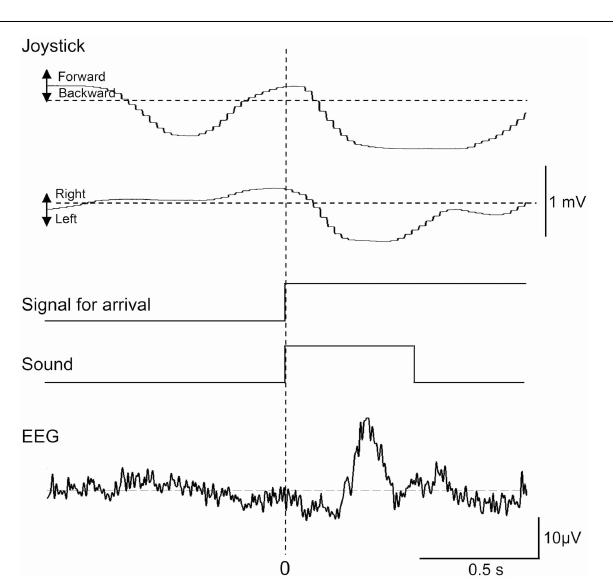
FIGURE 3 | Representative recordings of joystick movements, EEGs, and event signals from one subject upon entering a spatial reference point in the test phase. Signal for arrival indicates arrival at the spatial reference